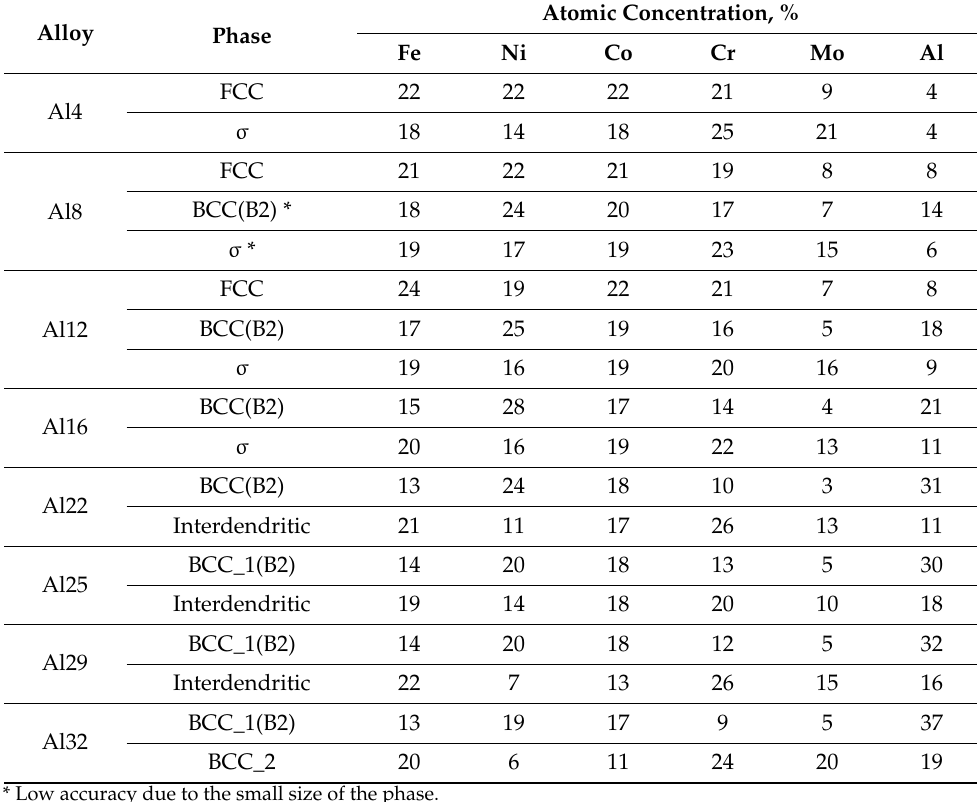
Figure 4. SEM microphotographs of the Al22, Al25, and Al32 alloys. σ -phase — the lightest,